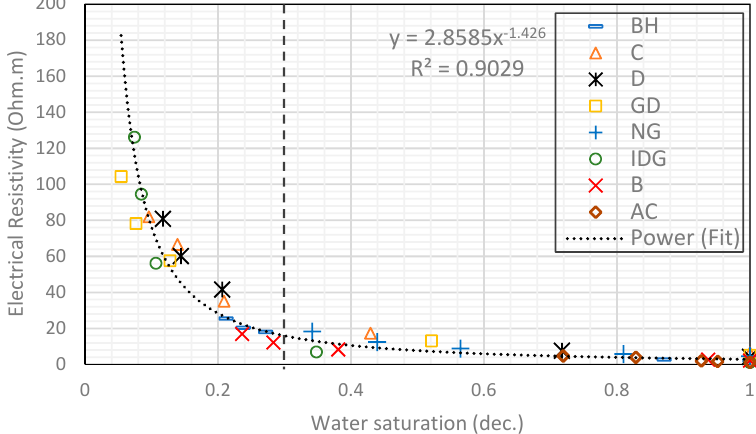
Figure 3. Power-law relationship between electrical resistivity and water saturation in a gas–water system.